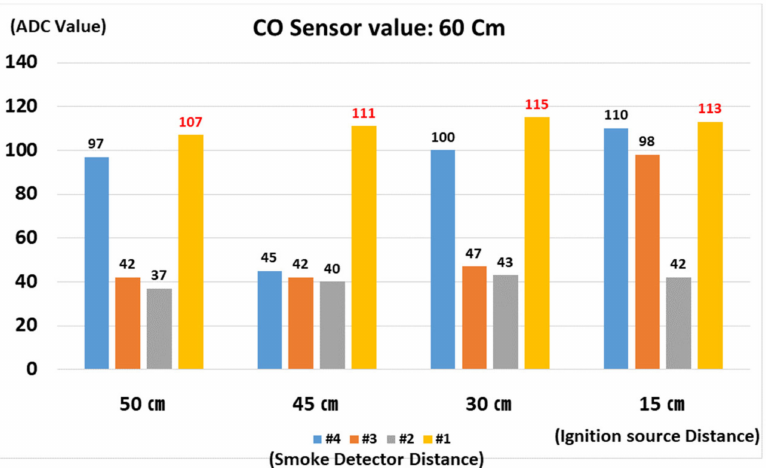
Figure 17. Carbon monoxide detection concentration for ignition source height of 60 cm. The highest CO concentration was measured by the CO sensor of smoke detector #1, which was the closest to the exhaust